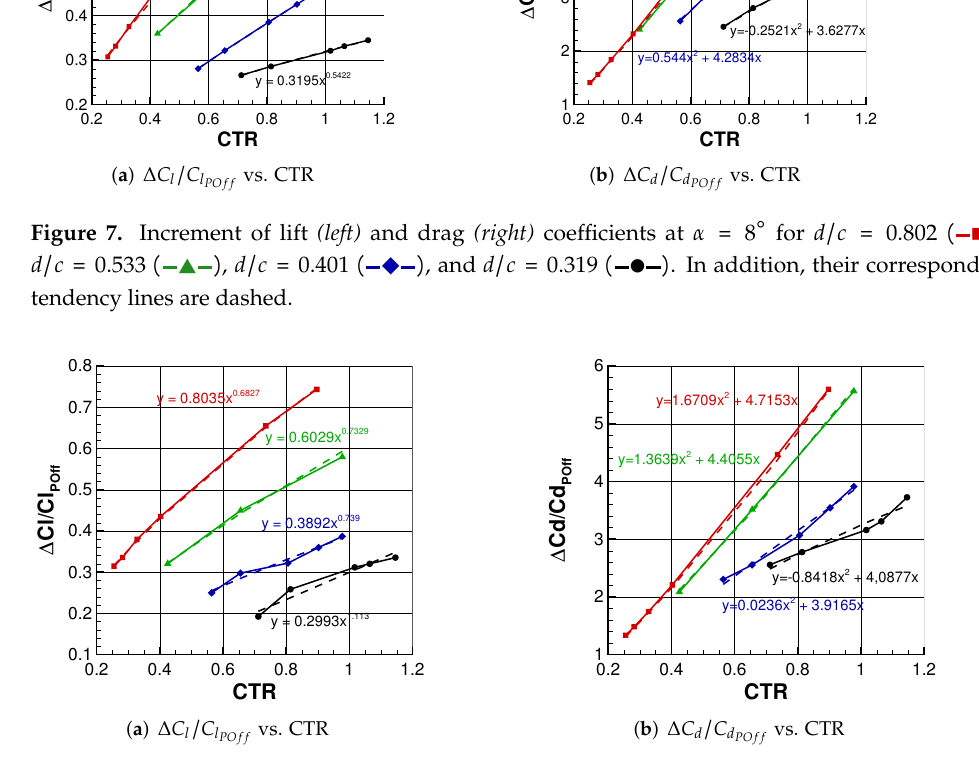
Figure 8. Increment of lift (left) and drag (right) coefficients at α = 10 d / c = 0.533 ( ▲ ) , d / c = 0.401 ( ◆ ) , and d / c = 0.319 ( ● ) . In addition, their corresponding tendency lines are dashed.